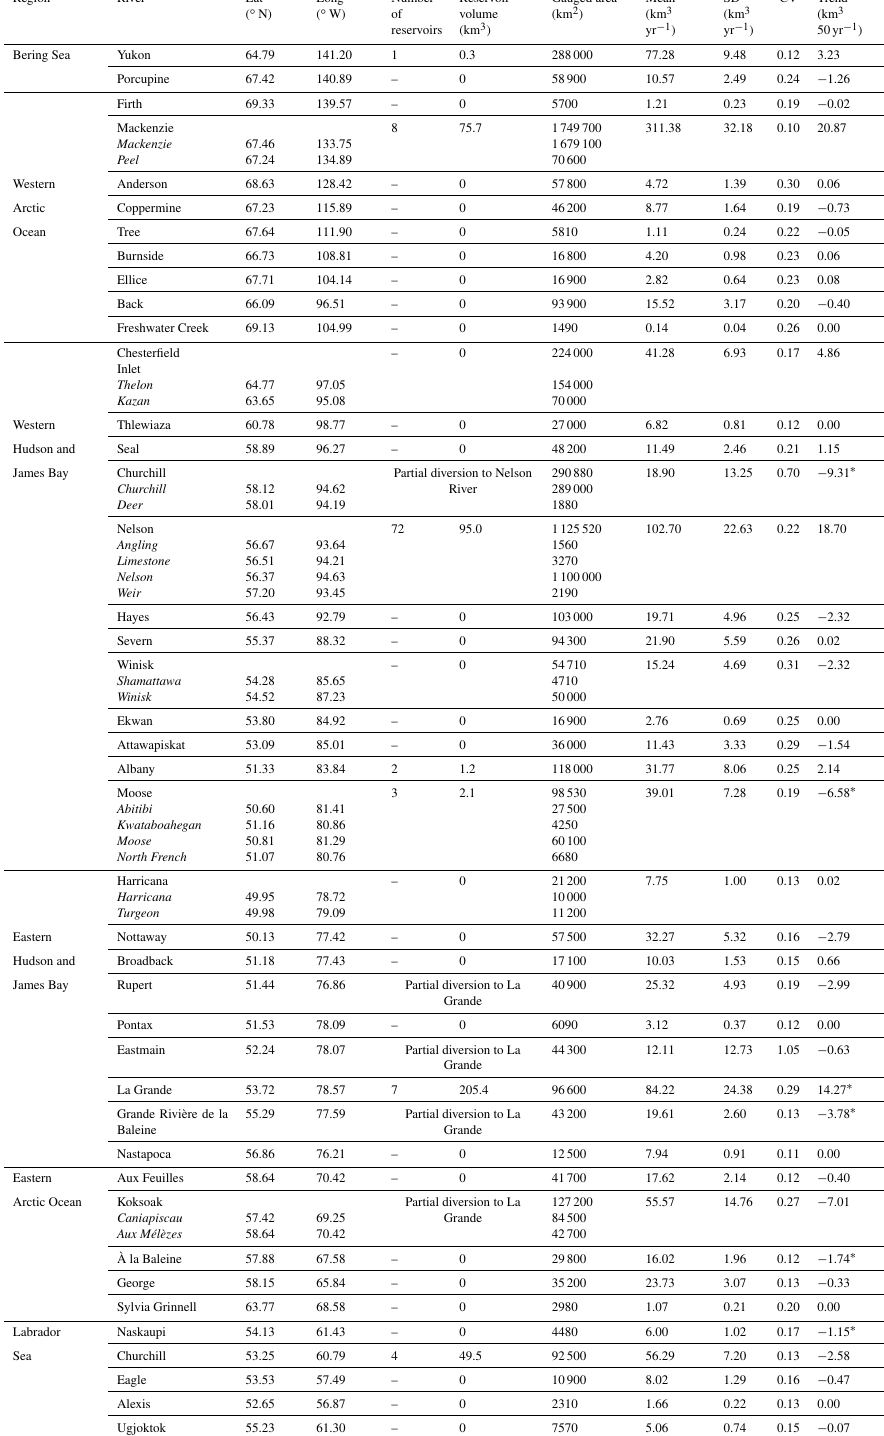
Table 1. List of 42 rivers (from west to east) and their tributaries (italicised) that discharge into six drainage basins in northern Canada with geographical coordinates of the recording gauge nearest to the mouth, number and volume of artificial reservoirs, contributing area that is gauged, the mean, standard deviation (SD), coefficient of variation (CV) and trend in annual river discharge, 1964–2013. Reservoir information is sourced from Lehner et al.